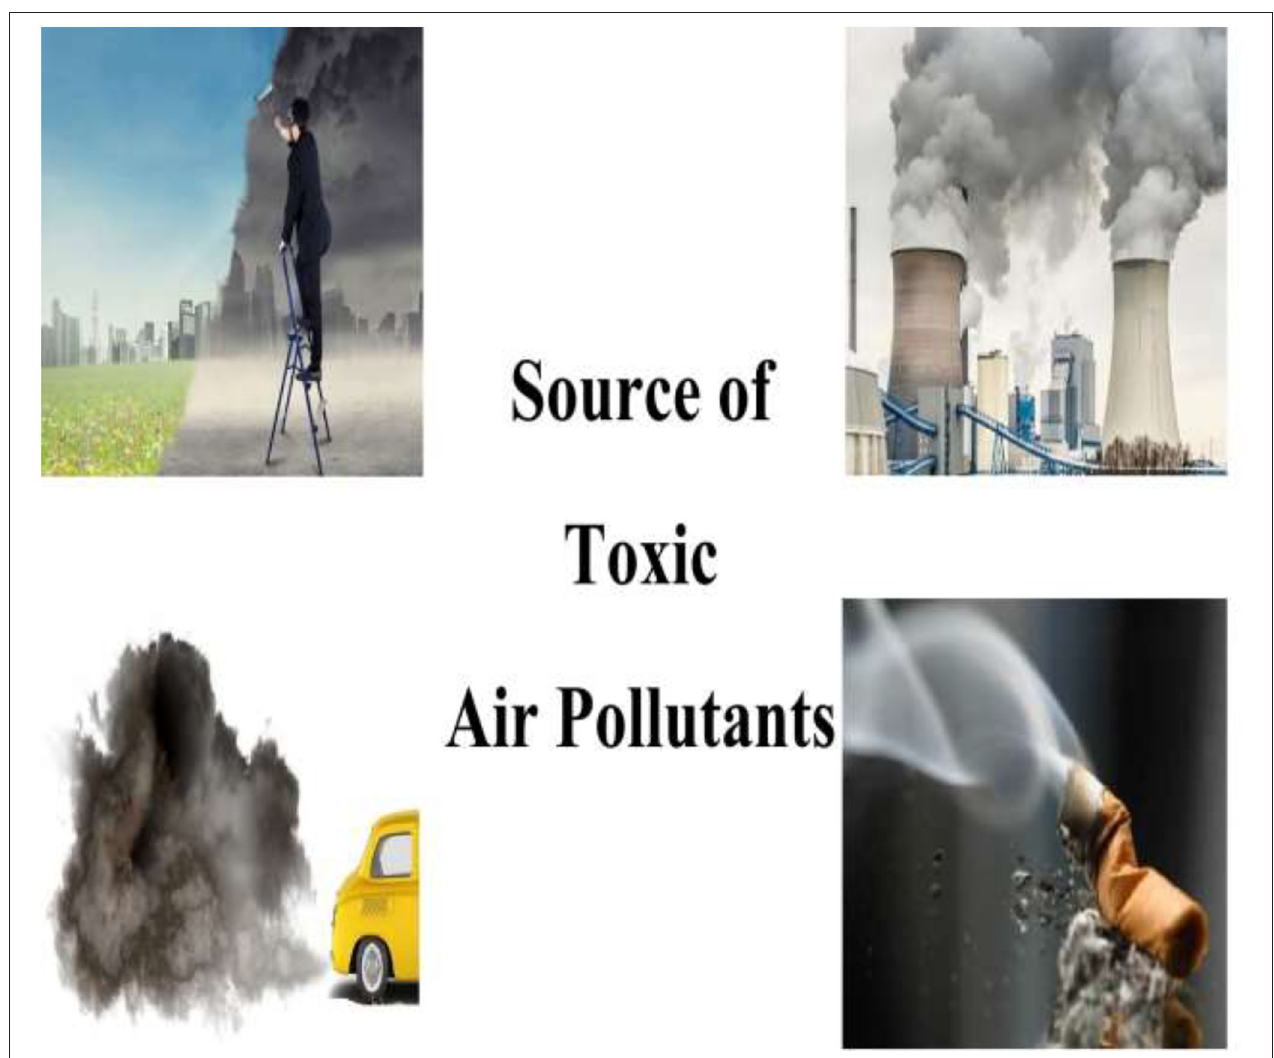
FIGURE 3 | Sources of emission of toxic air pollutants in the